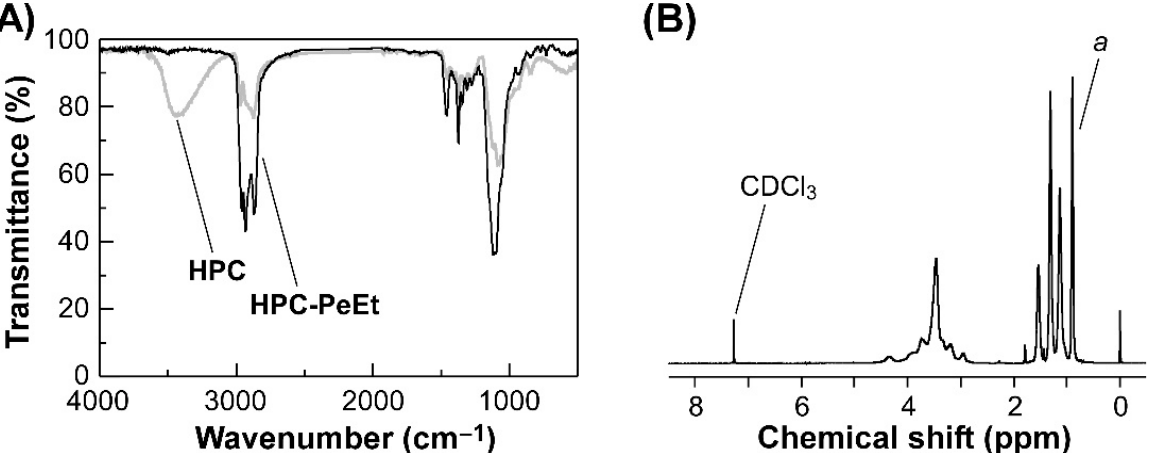
Figure 2. ( A ) FT-IR spectra of pristine HPC (gray line) and HPC-PeEt (black line). ( B ) 1 H-NMR spectrum of HPC-PeEt in CDCl 3 . The peak a is assigned to terminal methyl groups in the pentyl ether side-chains of HPC-PeEt.